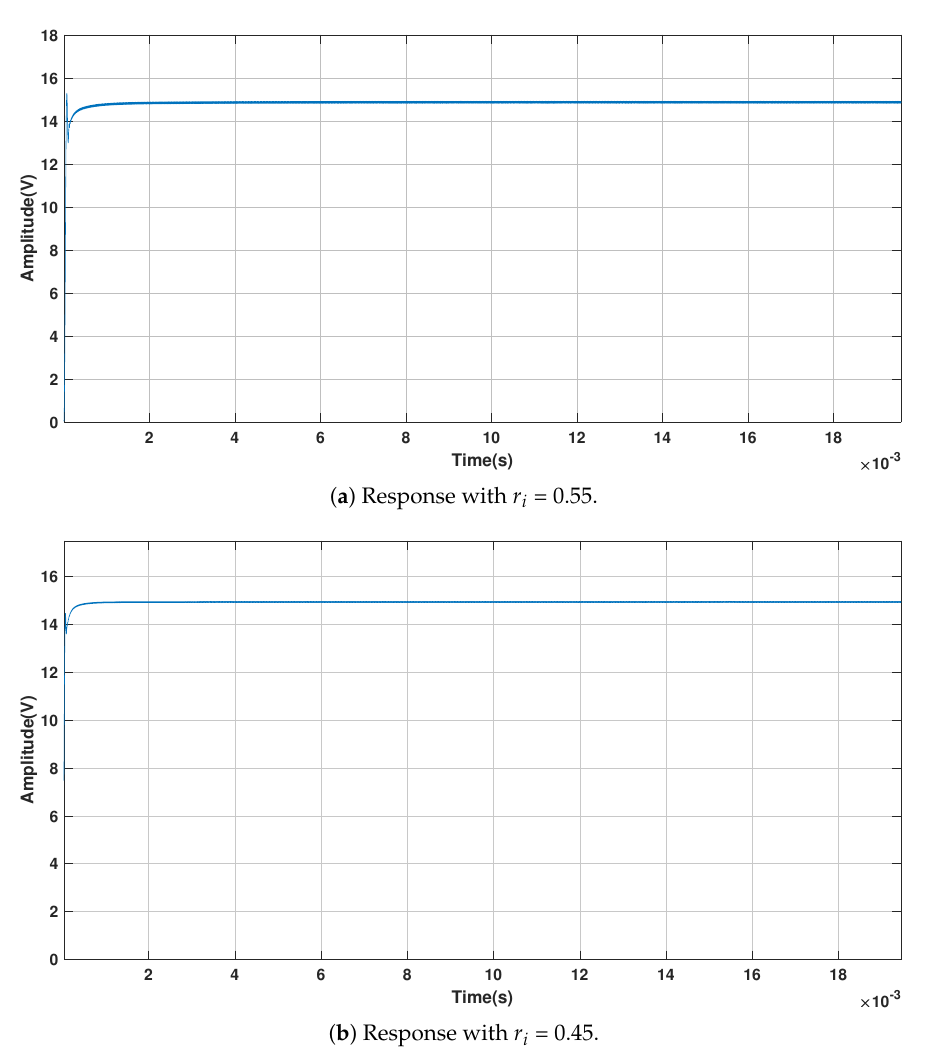
( a ) Response with r i = 0.55.